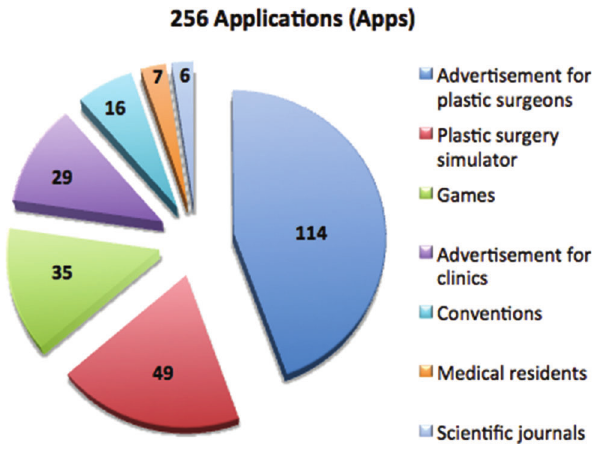
Figure 1 - Applications found in the App Store.